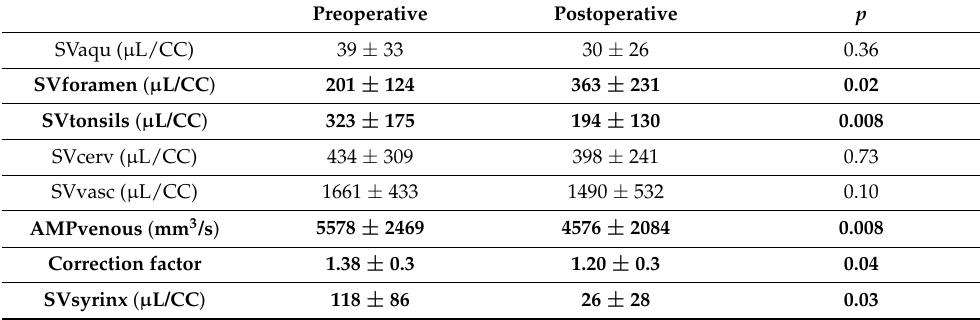
Table 4. Hemodynamic and hydrodynamic parameters evolution before and after surgery. CC: cardiac cycle, SVaqu: stroke volume of CSF in Sylvius aqueduct, SVforamen: stroke volume of CSF at the foramen magnum level, SVtonsils: stroke volume of tonsils (it is analyzed by a semi-automatic segmentation of the tonsils according to the same method as the CSF, this allows a quantification of the pulsatility of the tonsils during a cardiac cycle), SVcerv: stroke volume of CSF at cervical level, SVvasc: stroke volume of arteriovenous system, AMPvenous: amplitude of venous flow curve, correction factor: when >1, it shows that the jugular veins require an accessory venous pathway to drain all cerebral blood flow, SVsyrinx: stroke volume into the syringomyelia. Significant results are shown in